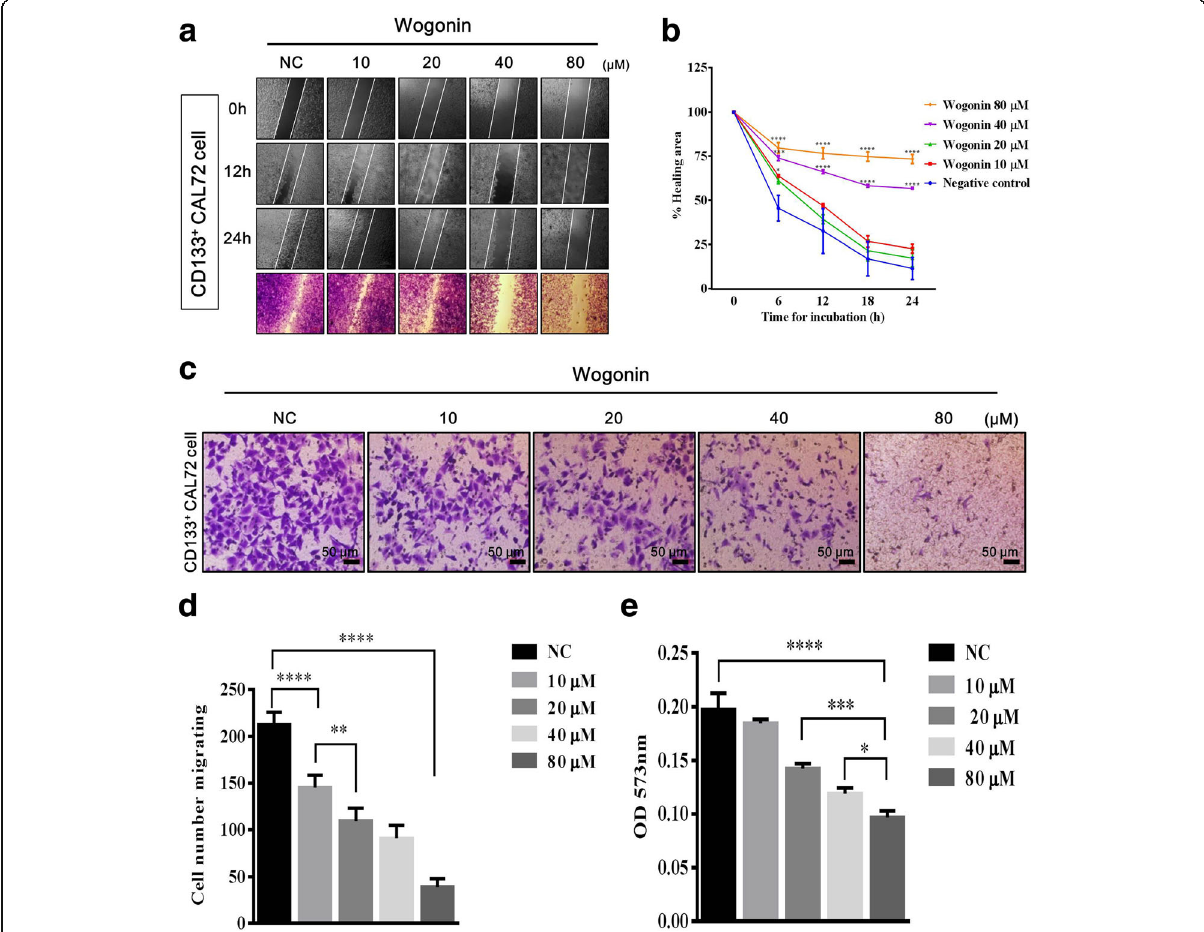
Fig. 2 Effect of Wogonin on the migration ability of CD133 + CAL72 CSC. a Wound healing assay showed that the rate of healing decreased after Wogonin treatment (0, 10, 20, 40, and 80 μ M). b The percentage of healing area was constrained by Wogonin treatment (0, 10, 20, 40, and 80 μ M), as measured by ImageJ software at 24 h post treatment. c Migration of CD133 + CAL72 cells was inhibited by Wogonin treatment (0, 10, 20, 40, and 80 μ M), as visualized by staining with 0.5% crystal violet. d The number of migrating cells was evaluated in five random fields in each trans-well insert exposed to varying concentrations of Wogonin (0, 10, 20, 40, and 80 μ M). e OD 573nm measurement after destaining with methanol and acetic acid. All experiments were performed in triplicates. Data are represented as mean ± SEM ( n = 3). ∗ P < 0.05, ∗∗ P < 0.01, *** P < 0.001, **** P <